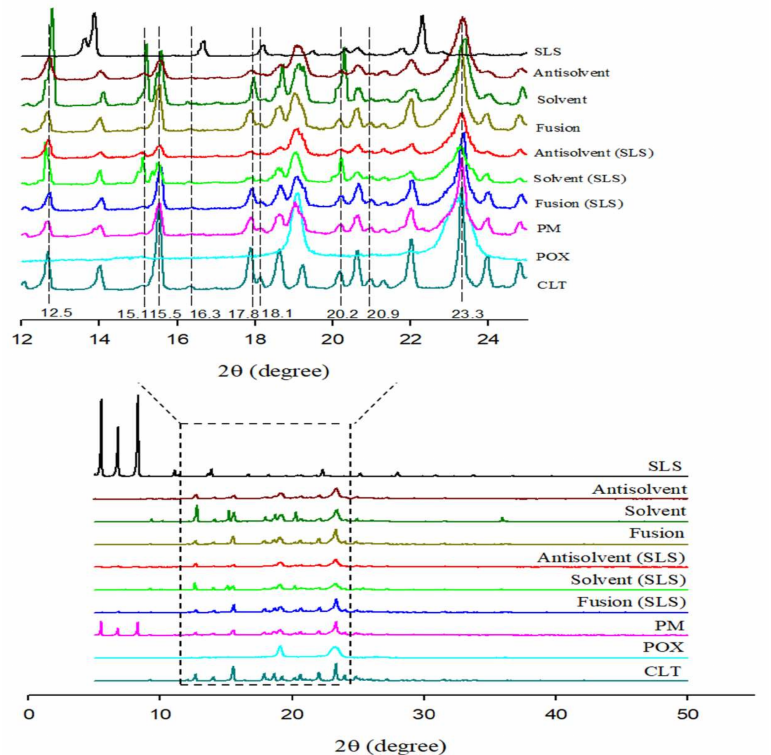
Figure 4. Powdered X-ray diffraction patterns of pure cilostazol (CLT), poloxamer, sodium lauryl sulfate (SLS), physical mixture (PM), and solid dispersions